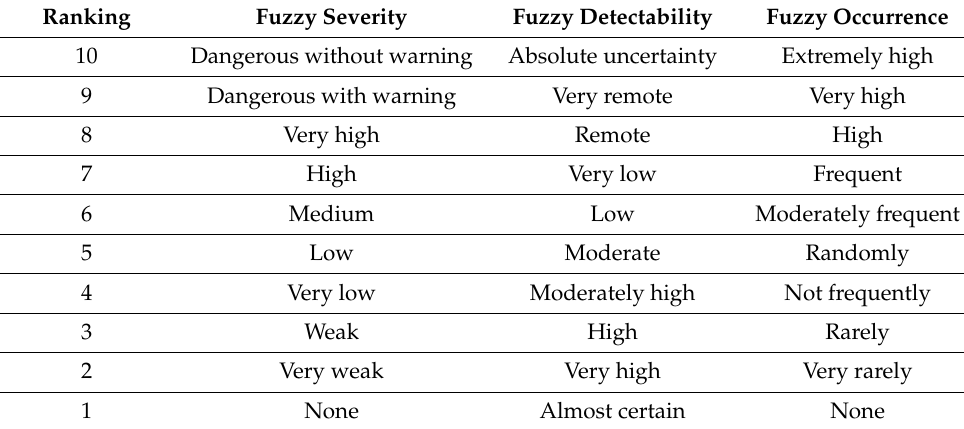
Table 2. Fuzzy set of output variables after the first stage of fuzzy logic systems that represent inputs to fuzzy RPN FIS.